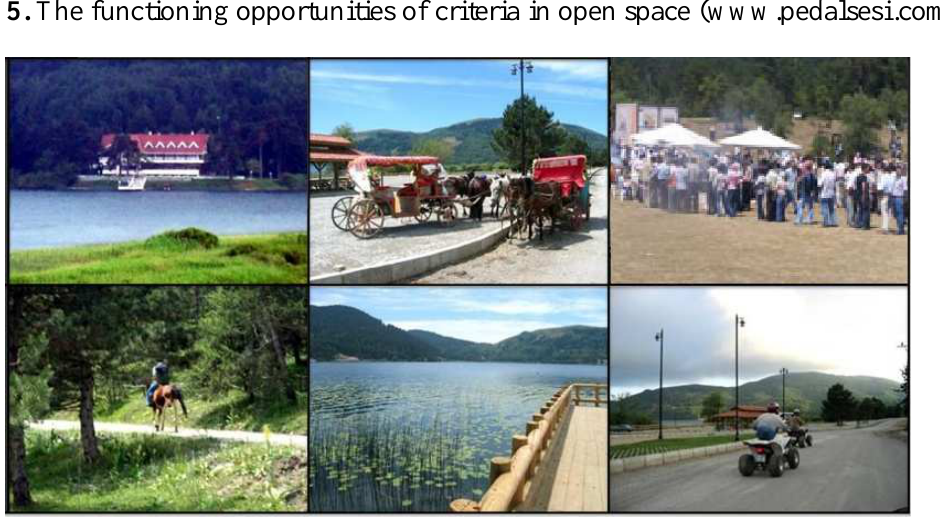
Figure 5. The functioning opportunities of criteria in open space